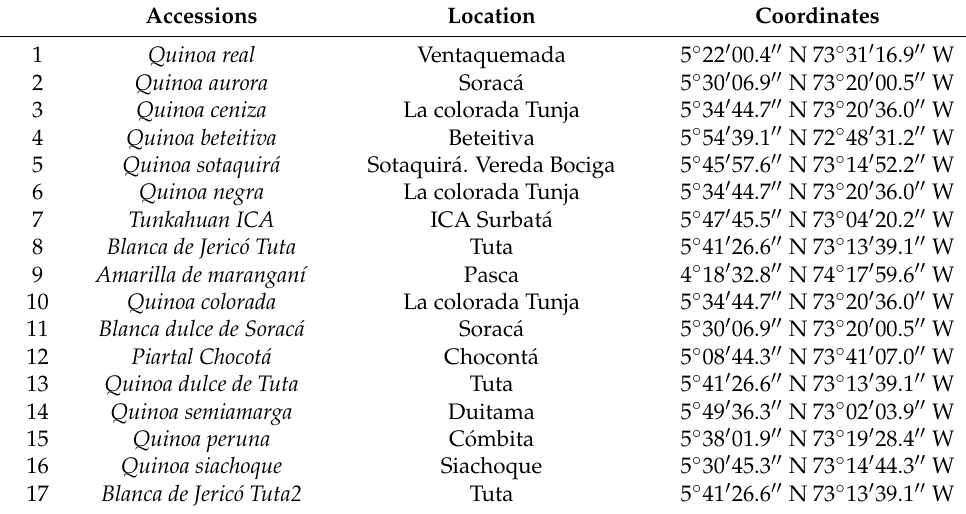
Table 2. Sites of origin of the evaluated quinoa ( C. quinoa )